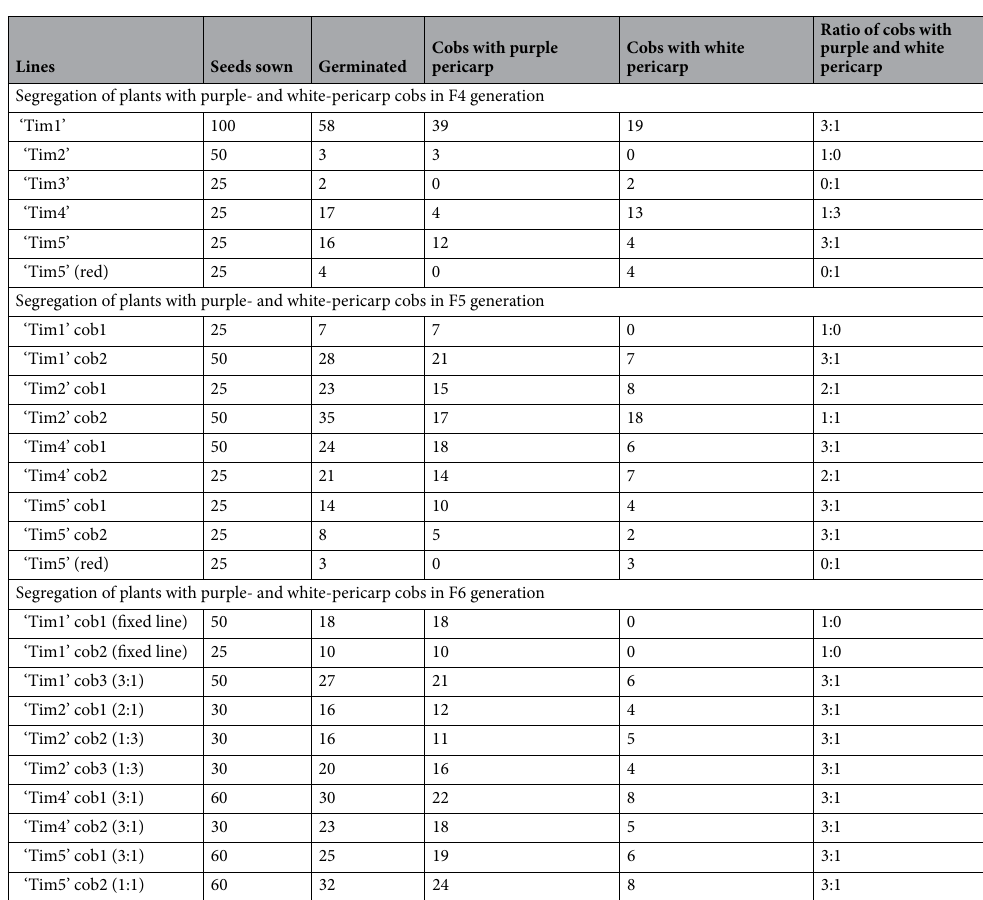
Table 2. Phenotypic data of F4, F5 and F6